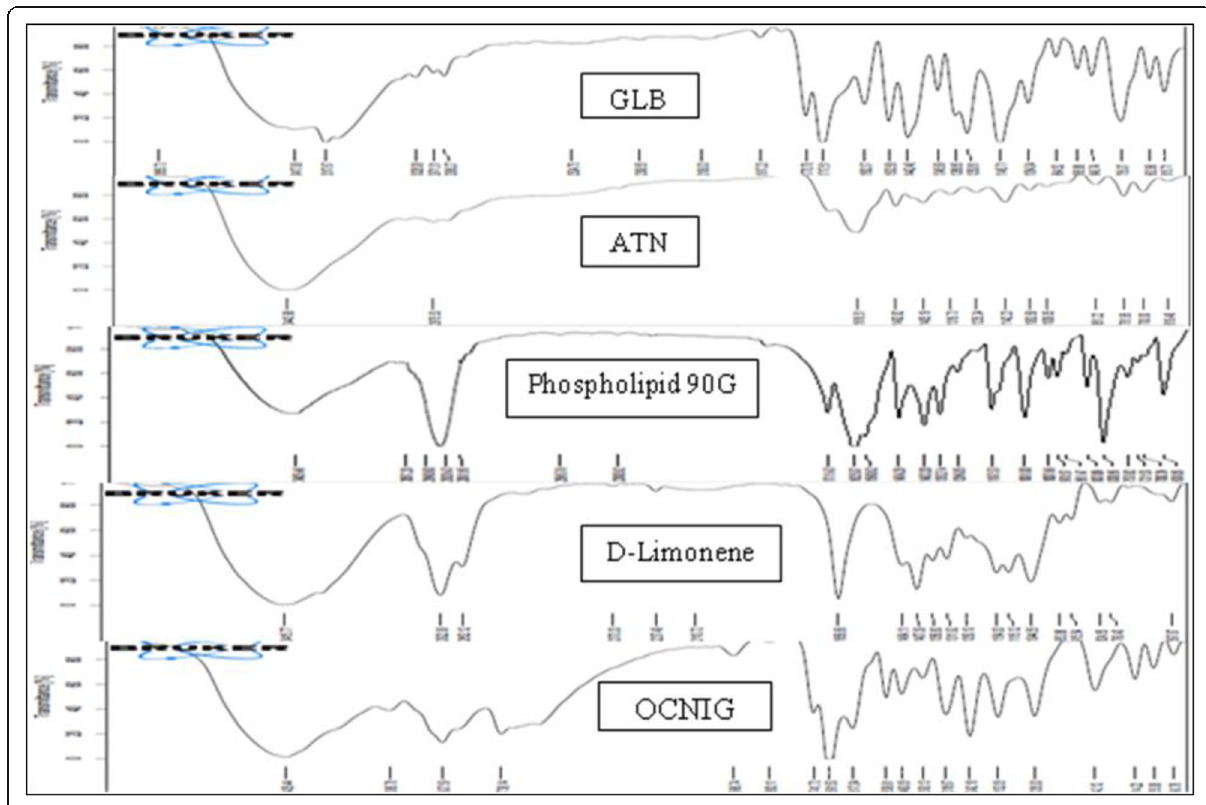
Response 3 (Y3): effect of independent variables on flux of